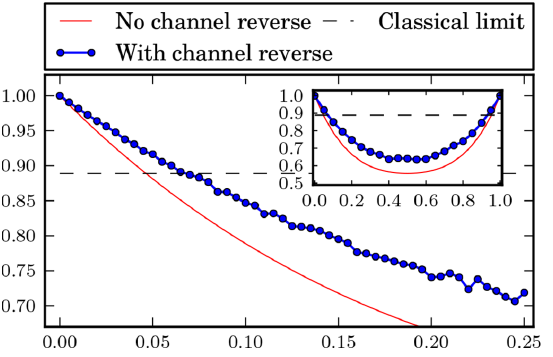
Figure 4. Depolarising channel. Probability of winning the pseudo- telepathy game with and without the use of our approach as a function of the noise parameter a for the depolarising channel. The inset shows the probability of winning for a M [0; 1].